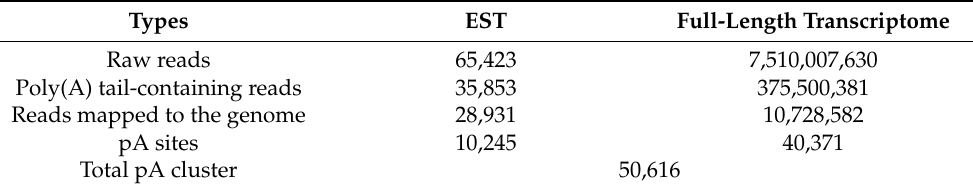
Table 1. Summary of all mRNA transcripts extracted from the EST and full-length transcriptome databases of Spodoptera frugiperda